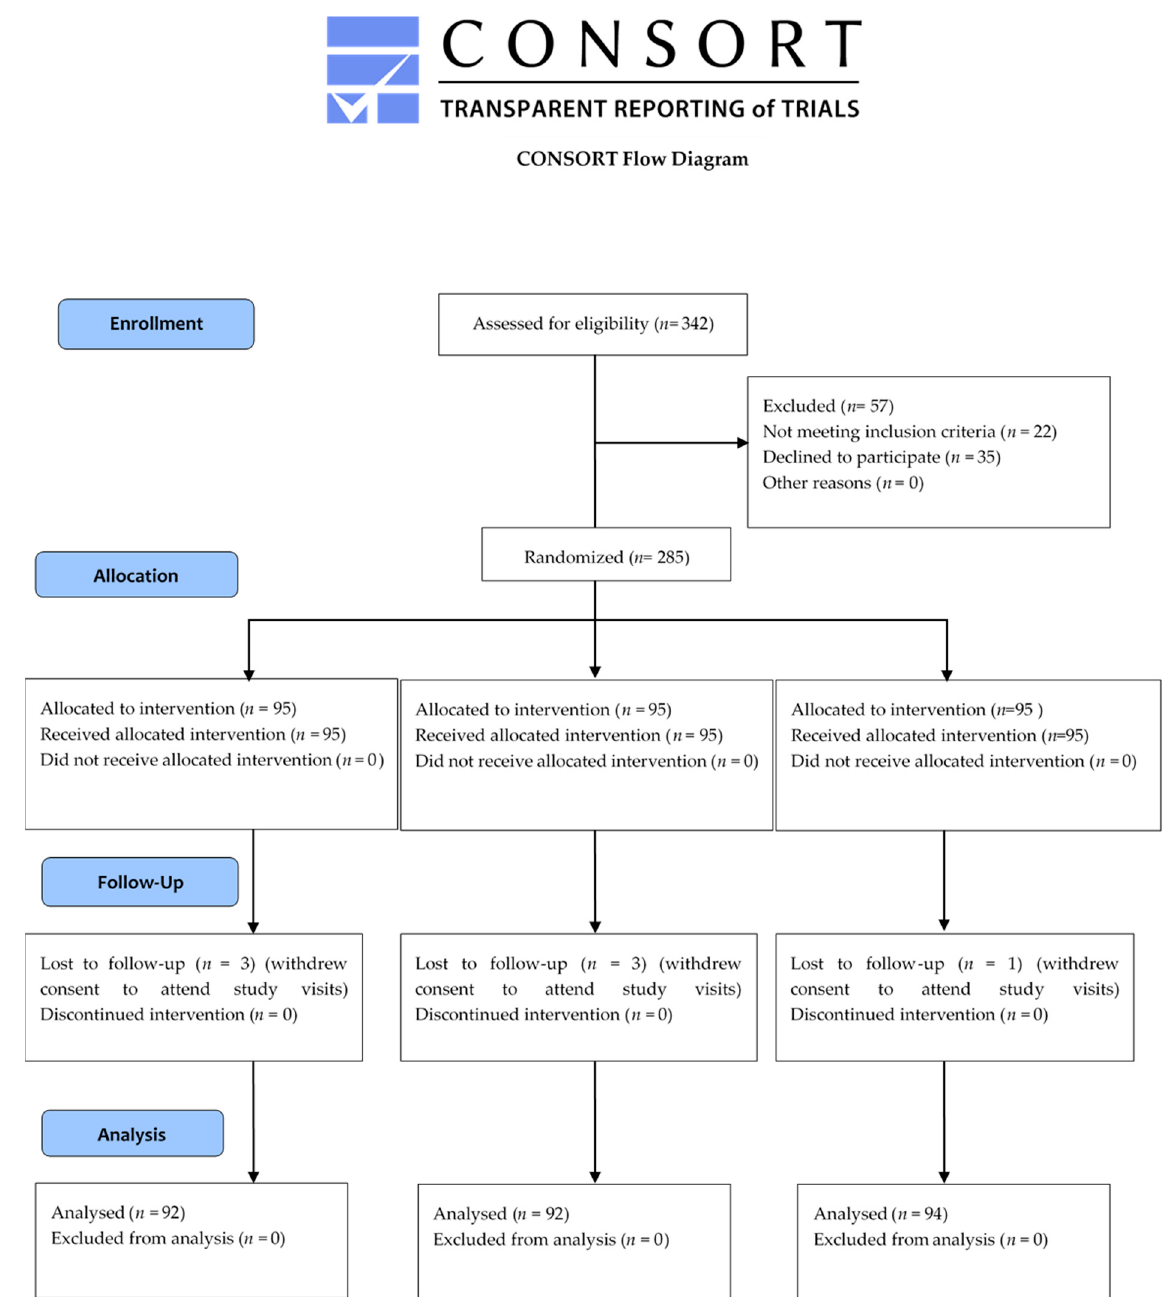
Figure 1. Consolidated Standards of Reporting Trials (CONSORT) flowchart depicting the study design and